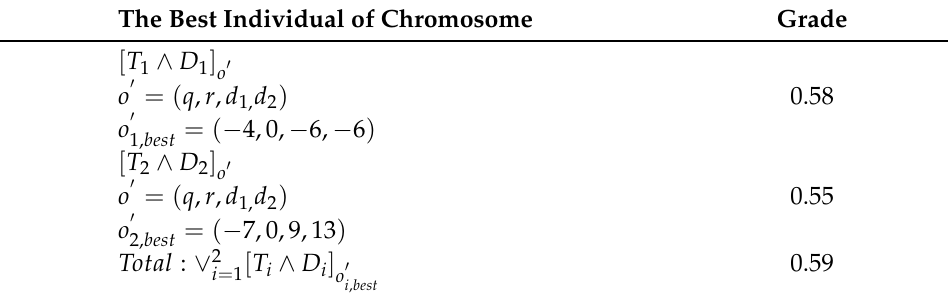
Table 2. Results for process Mod after applying GA.